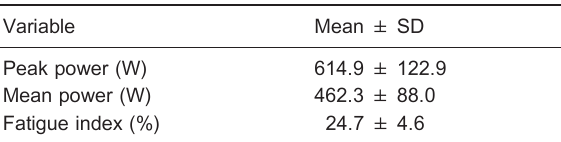
Table 1. Mechanical variables measured during the 30-s Wingate anaerobic test.